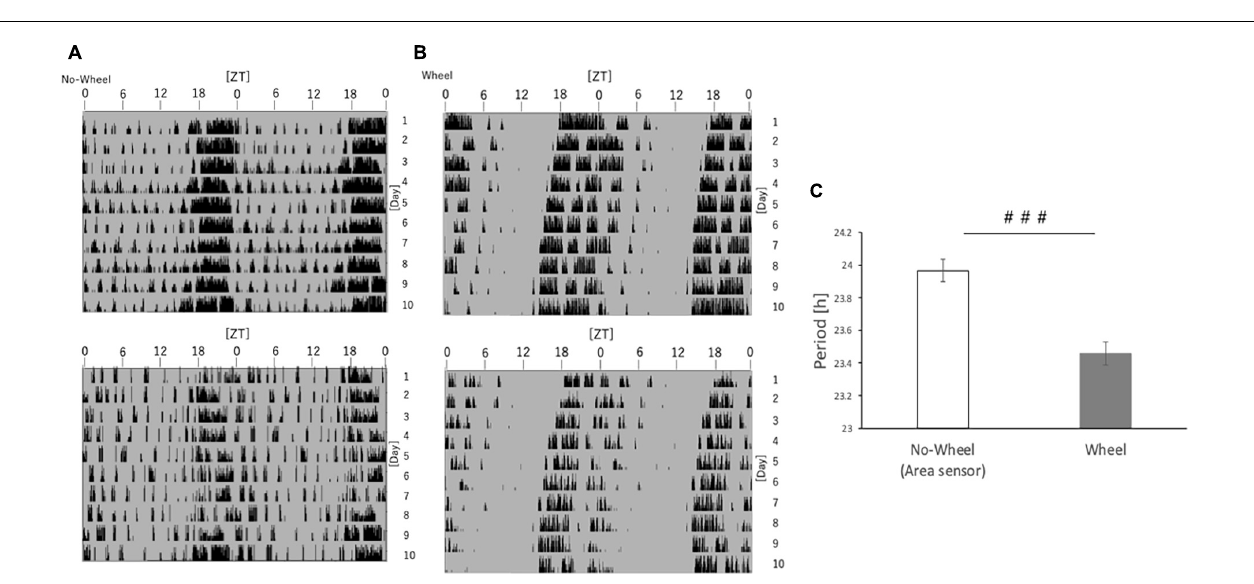
increasing corticosterone and noradrenaline levels (Sasaki et